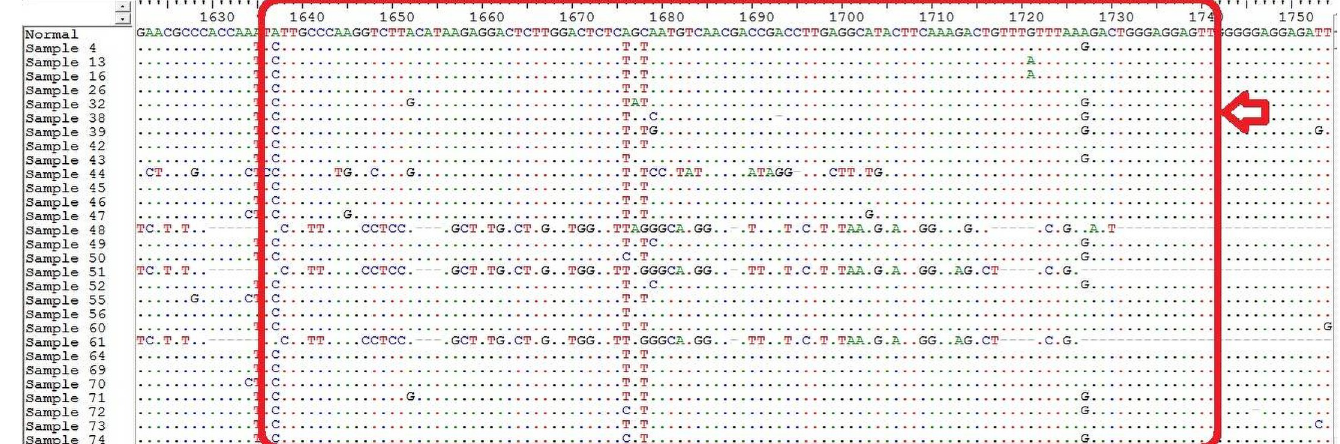
Fig 2. Enhancer II region nucleotide alignment showing comparison with the representative sequence (Normal). The dots represent similar nucleotides.